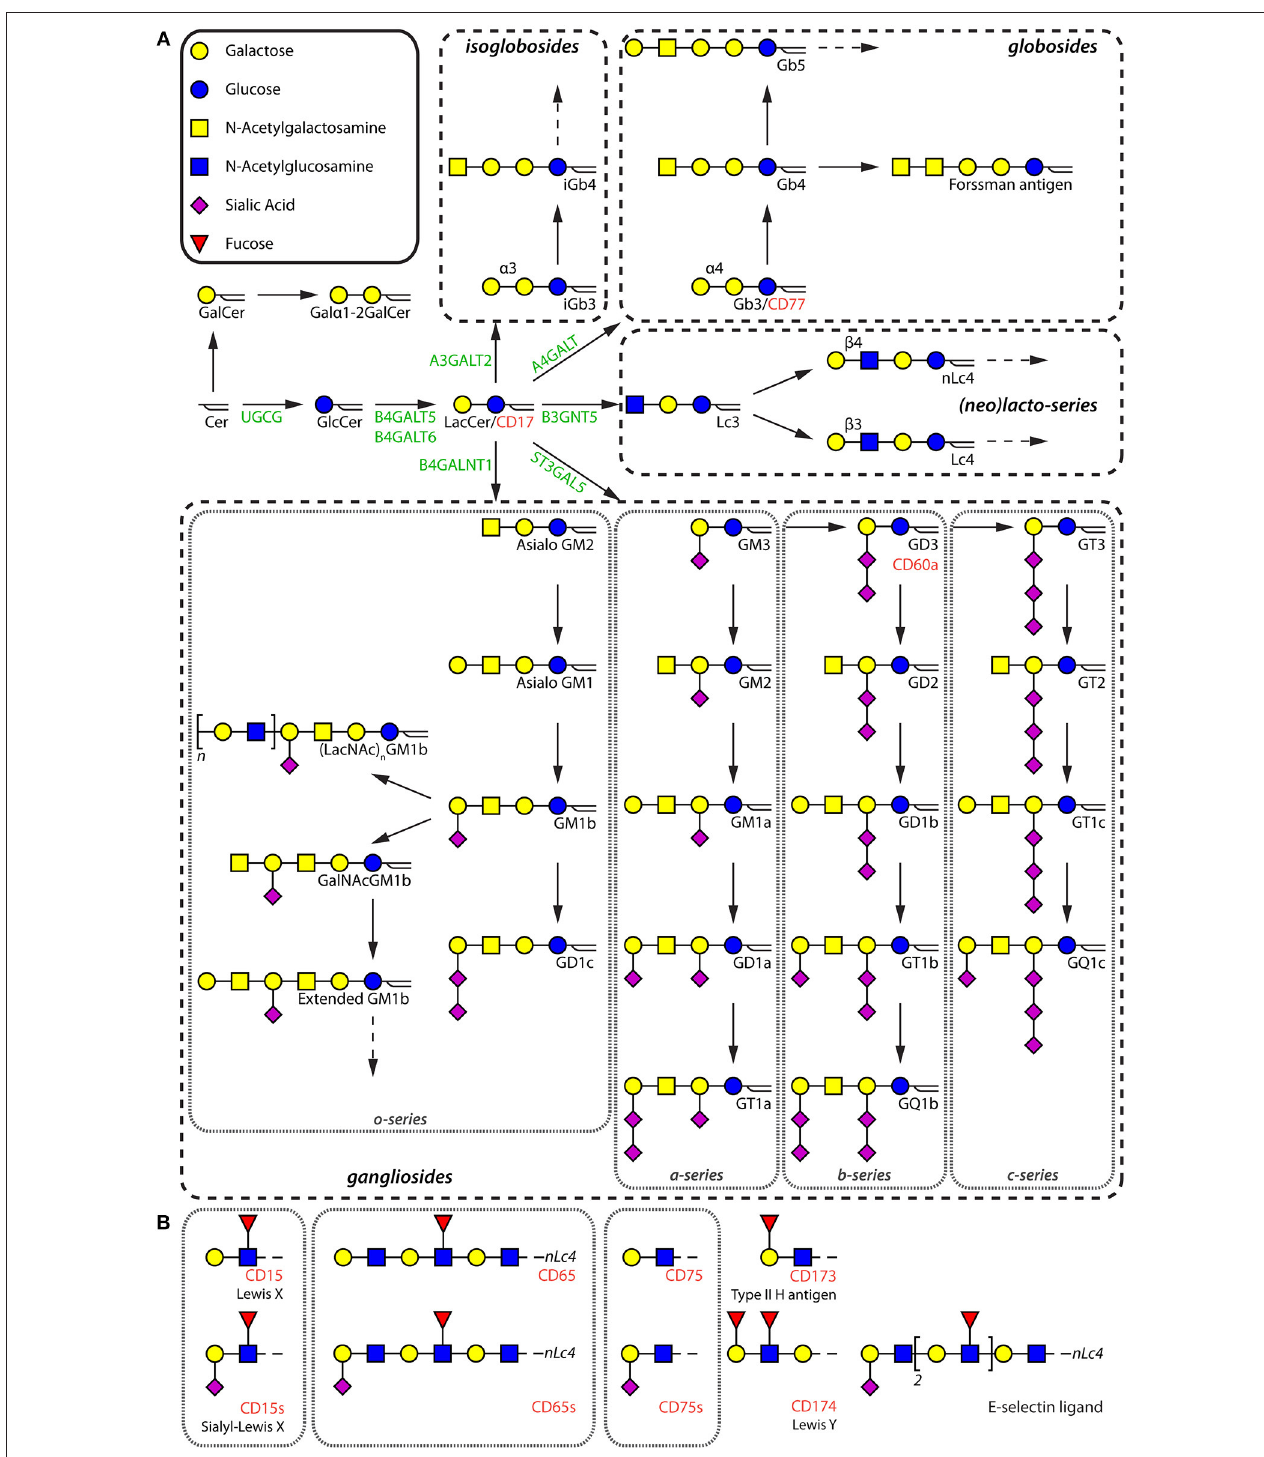
FIGURE 1 | Schematic diagram of the different types of GSLs. (A) Major GSLs expressed in immune cells and proposed GSL biosynthetic pathway. The key enzymes are in green. GSLs that have been given a cluster of differentiation (CD) number are annotated in red. (B) Terminal glycan motifs that have been given a CD number and the most prominent E-selectin ligand present on human